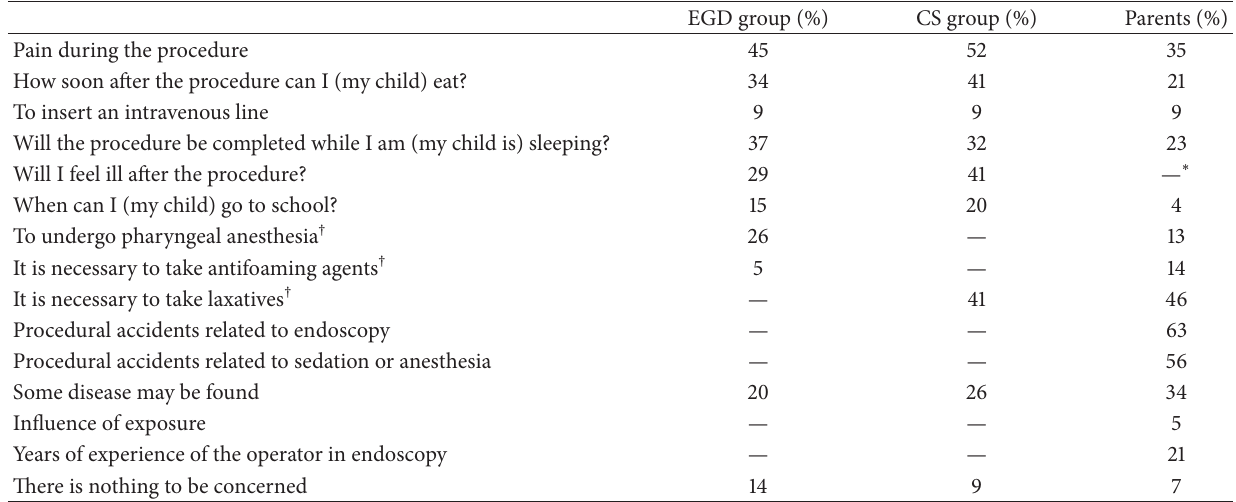
Table 2: Results of preendoscopy questionnaire for